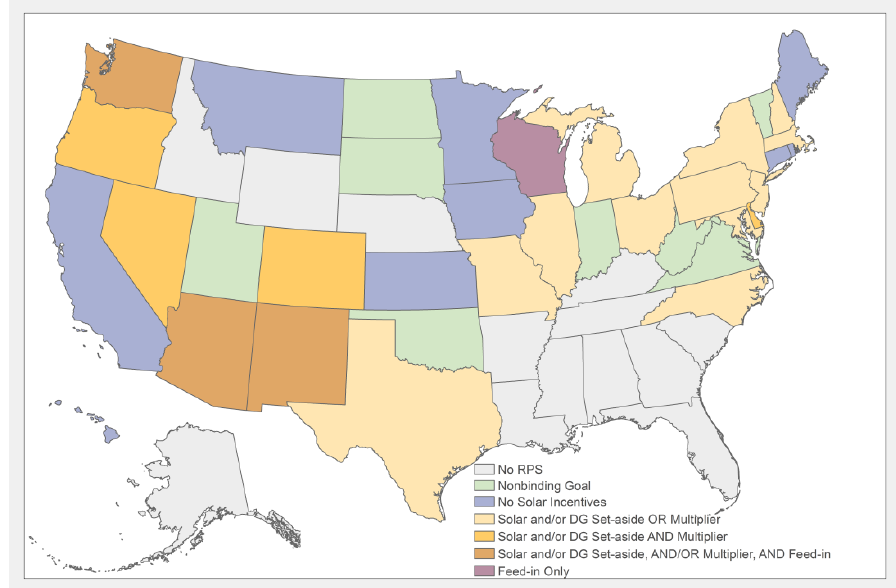
Figure 2. RPS provisions for solar and distributed energy technologies by state. Provisions for solar and distributed energy technologies include solar and/or distributed generation (DG) set asides, solar and/or DG multipliers, and feed-in tariffs. Data from the Database of State Incentives for Renewable Energy (DSIRE) [27] as well as previously published research